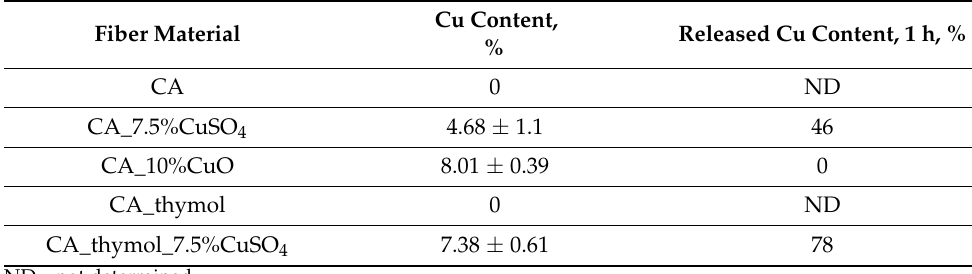
Table 3. The metal content and release of copper ions from CA filter